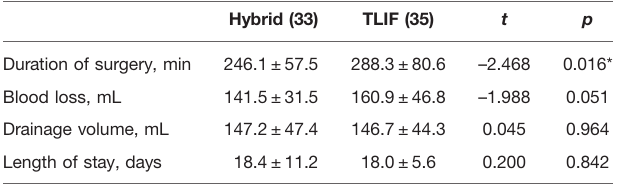
TABLE 3 | Surgical conditions.